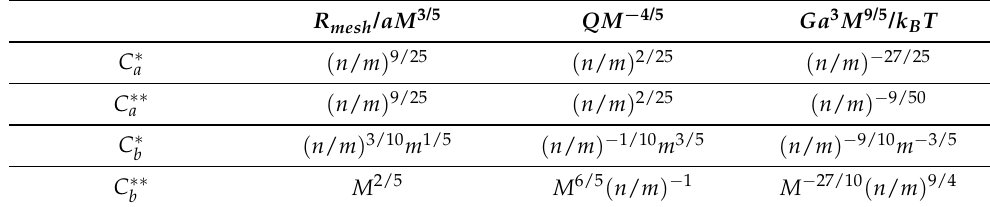
Table 1. Asymptotic power-law dependencies for normalized mesh size R mesh , swelling ratio Q , and bulk osmotic modulus G in a free-swelling hairy gel with DP M of strands in good solvent ( ν = 3/5).